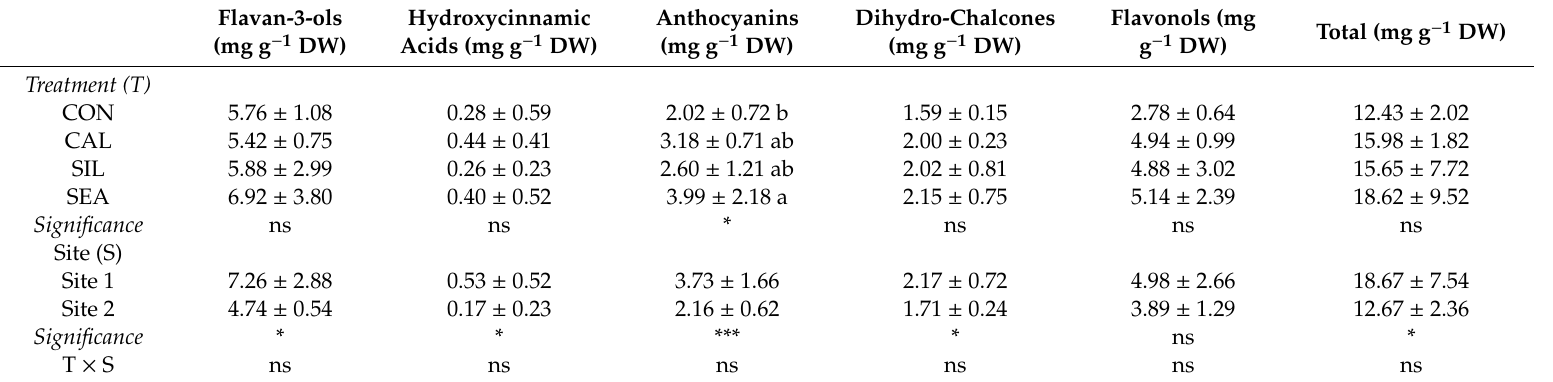
Table 4. Phenolic content in apple skin at harvest as a ff ected by treatments and sites 1